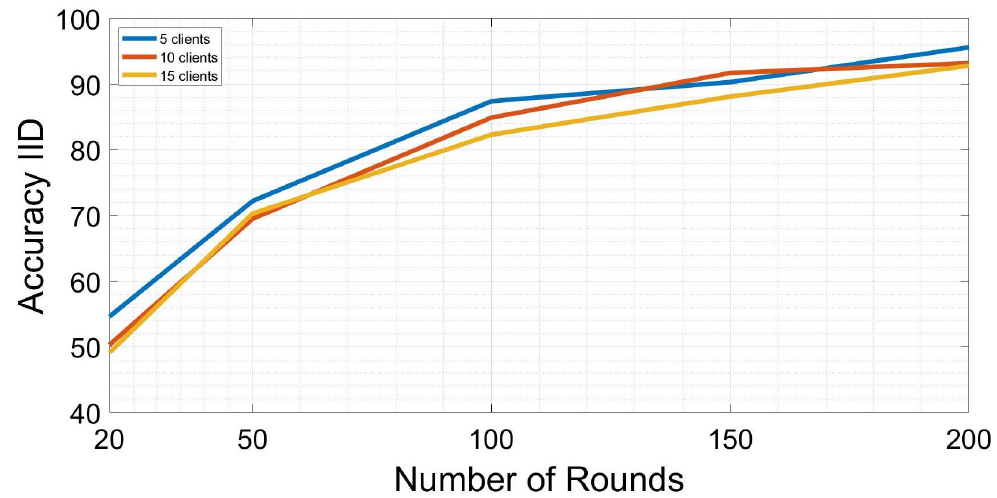
Figure 3. Accuracy in the scenario with IID data when varying the number of